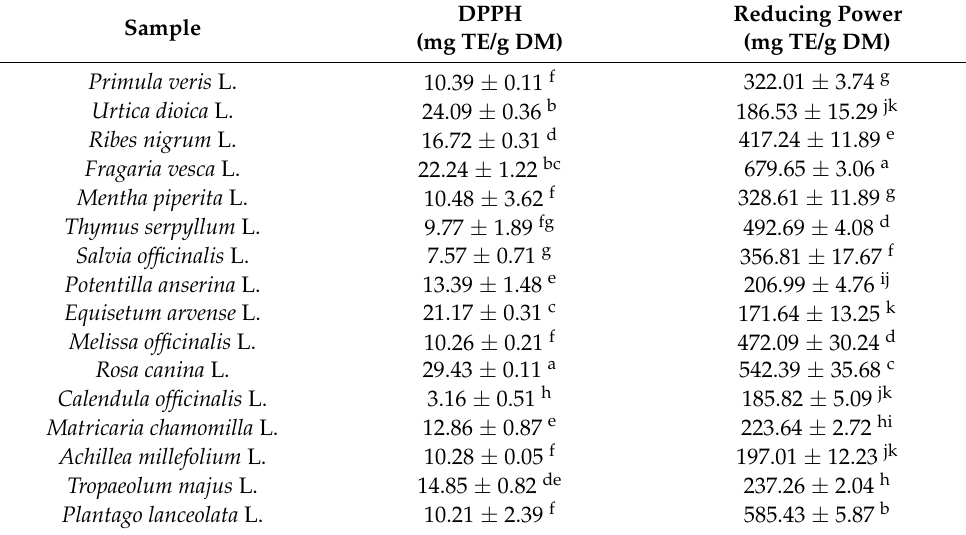
Table 1. Antioxidant activity of tested medicinal herbs.